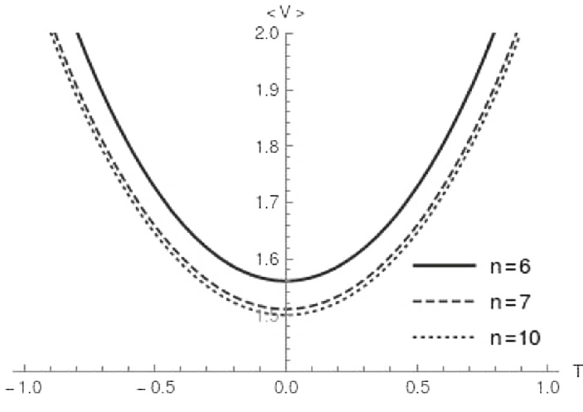
Fig. 5 Expectation value of volume < V = a 3 b n − 4